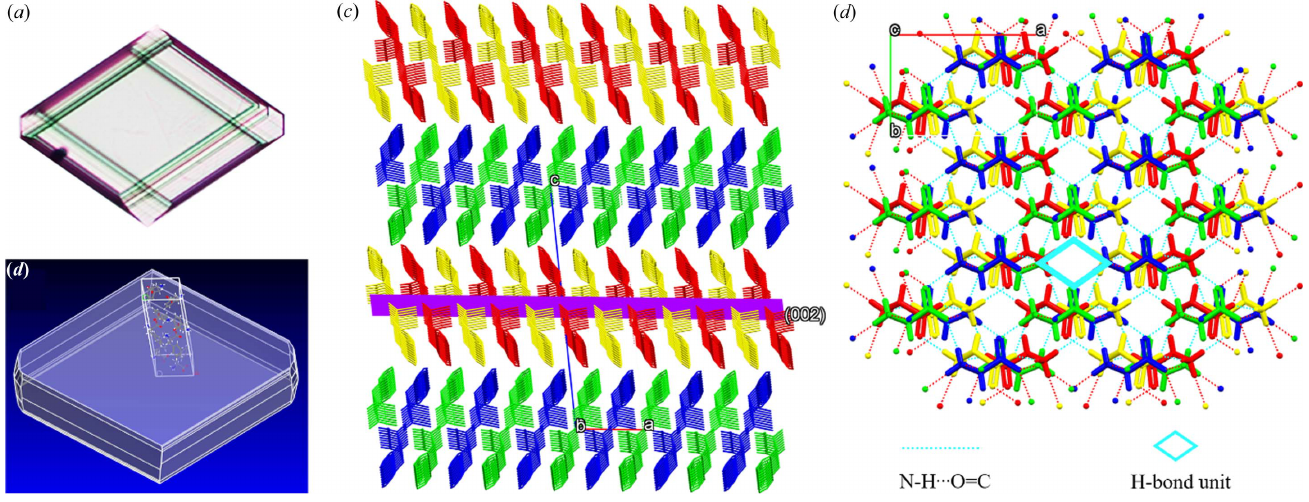
Figure 7 ( a ) Optical micrograph of plate-like l -Phe. ( b ) Equilibrium morphology calculation of l -Phe form I in Materials Studio (version 6.0; Gibbs, 1929), ( c ) Crystal structure of form I, viewed along the b axis. ( d ) Hydrogen-bonded network of form I, viewed along the c